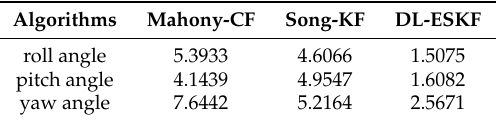
Figure 17. Yaw angle under dynamic conditions. Mahony-CF, Song-KF, and DL-ESKF attitude RMSE (degree) comparison under dynamic conditions.